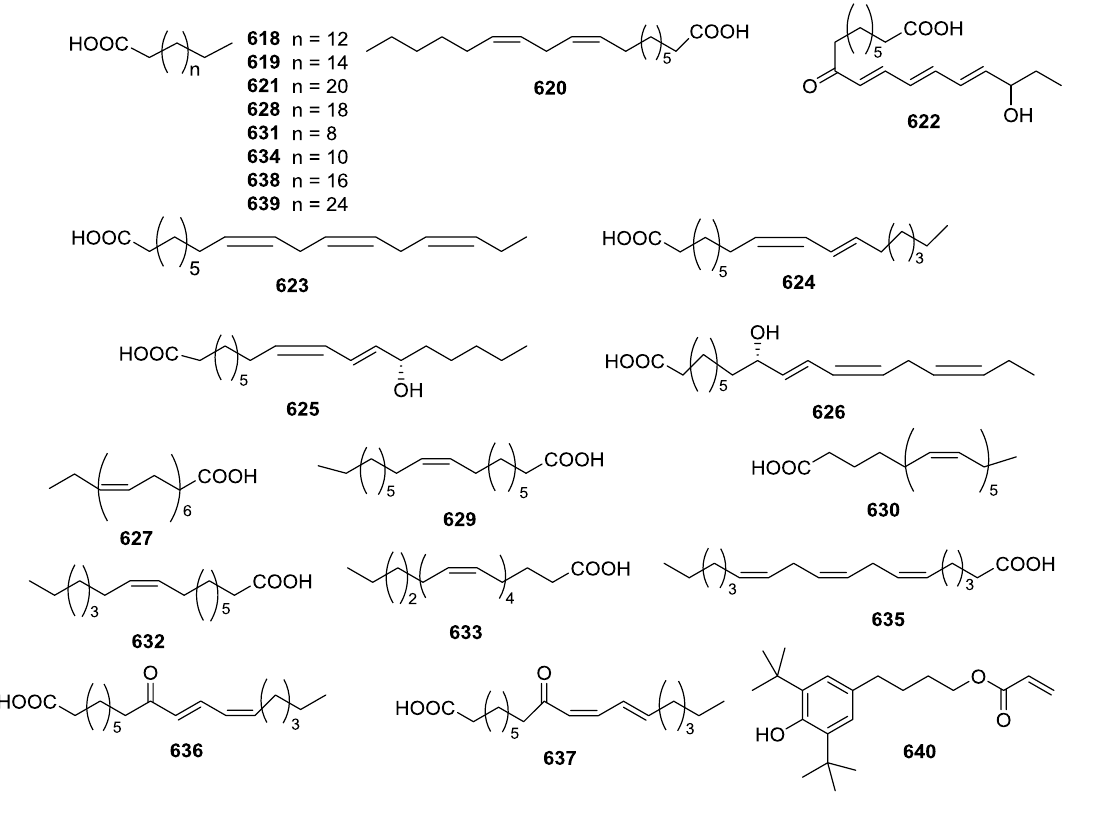
Fig. 15 Fatty acids and esters 618 – 640 from